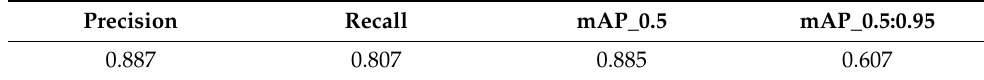
Table 2. Dataset test results for the performance baseline.